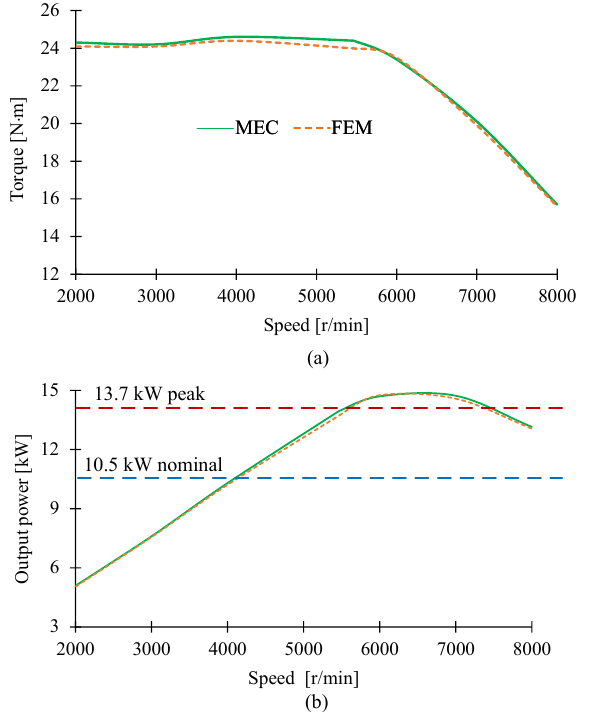
Figure 27. Motor characteristics for the peak operating point of the 12/16 SRM at 385 V DC link voltage: ( a ) torque–speed characteristics and ( b ) power–speed